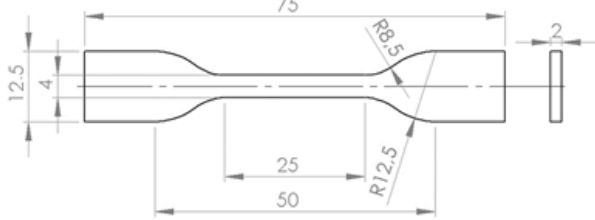
Figure 1. Outline of samples utilized in the static tensile material test.